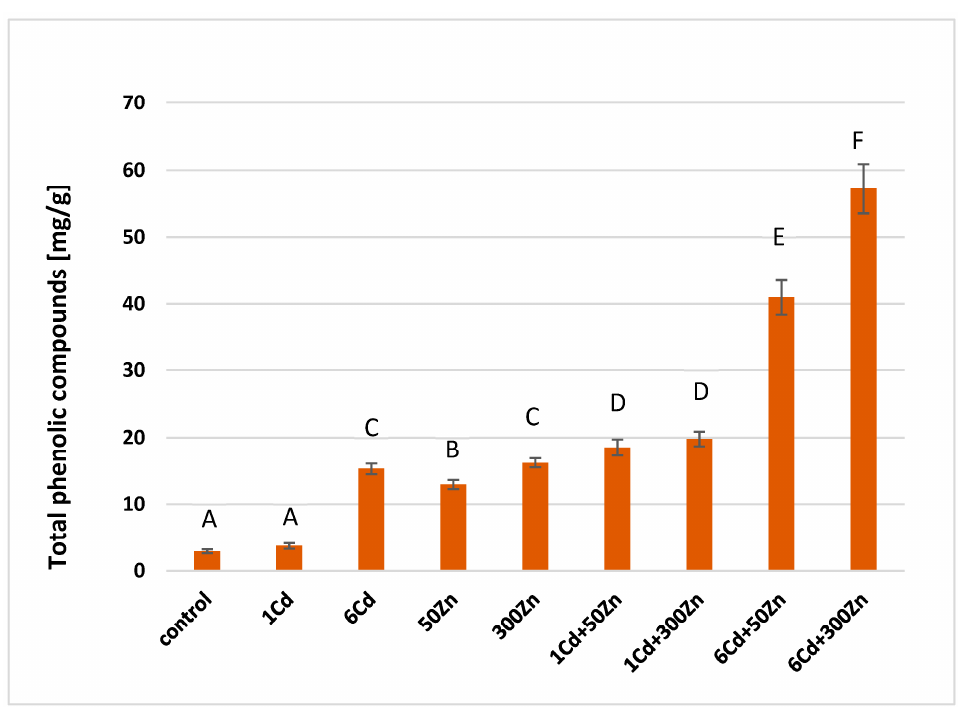
Figure 2. Concentrations of the total phenolic compounds in above ground parts of the lemon balm plants determined for control and all cadmium or zinc treatments with relevant standard deviations ( n = 5). Specific letters illustrate the statistically significant differences, as computed with Tukey’s HSD test ( p = 0.95). Symbols on the horizontal lines are the same as described in the caption for Figure 1.